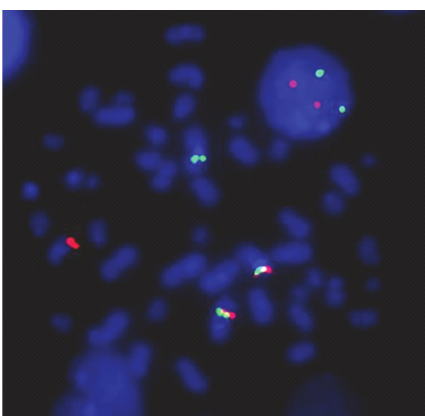
Figure 2: Identification of a new partner gene, RCSD1 , fused to ABL1 in acute lymphoblastic leukemia. Dual-color FISH using RP11-83J21 (labeled in spectrum orange) and RP11-232M22 (labeled in spectrum green) showing two fusion